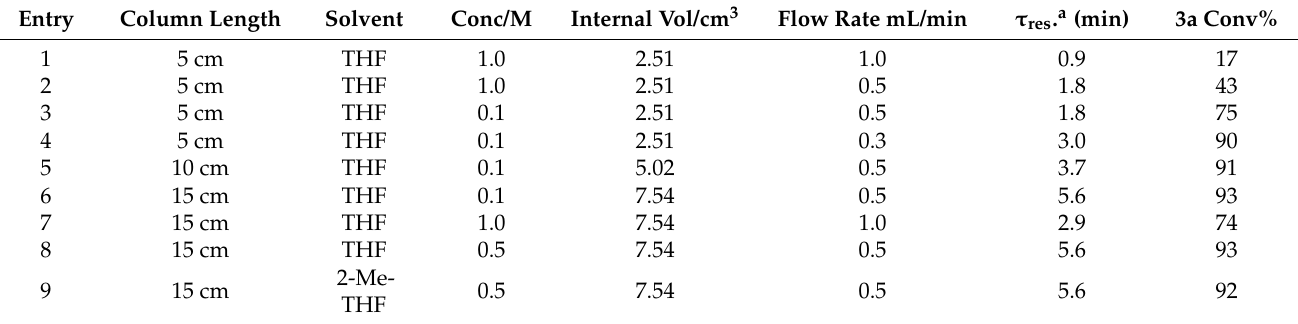
Table 2. Catalyzed synthesis of aldehyde 3a using AR-35 packed columns. Collected solutions were monitored by GC-MS analysis after 1 h reaction; a. τ res = residence time.